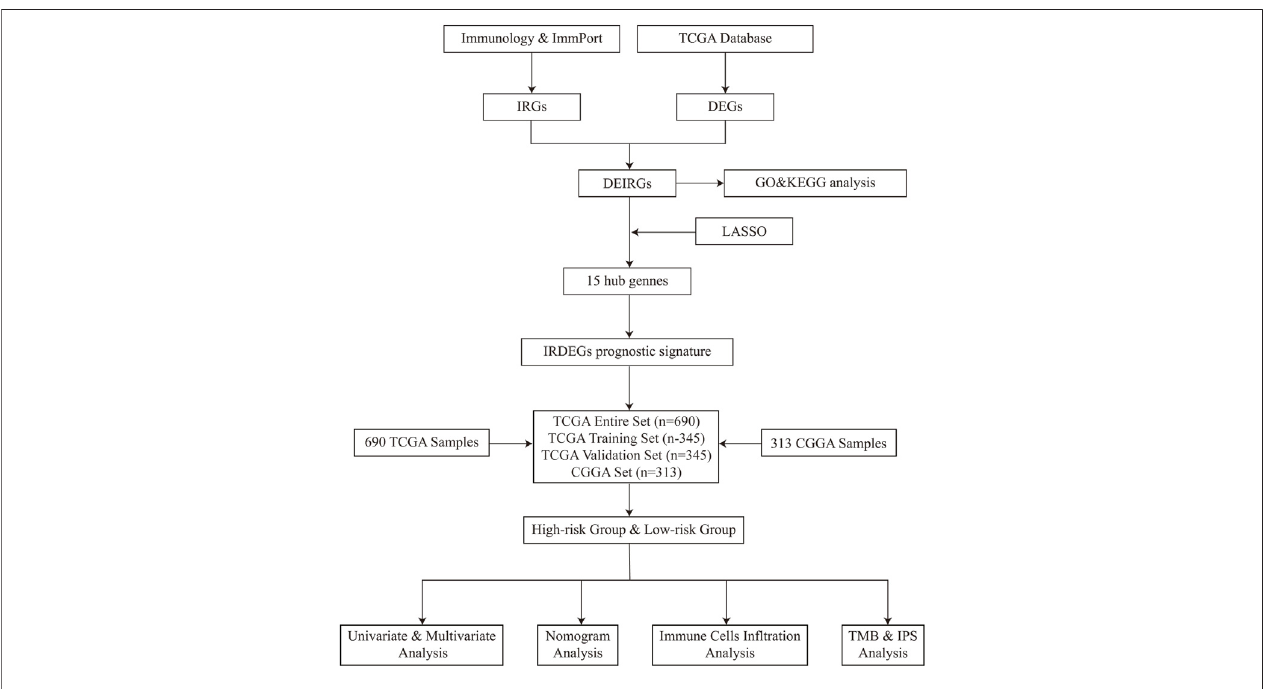
FIGURE 8 | The whole fl ow